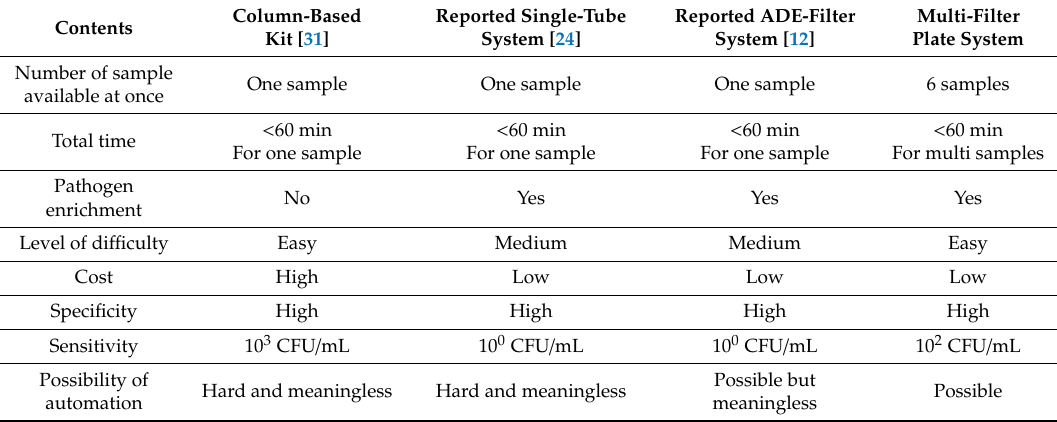
Table 3. Advantages and disadvantages of di ff erent NAs isolation